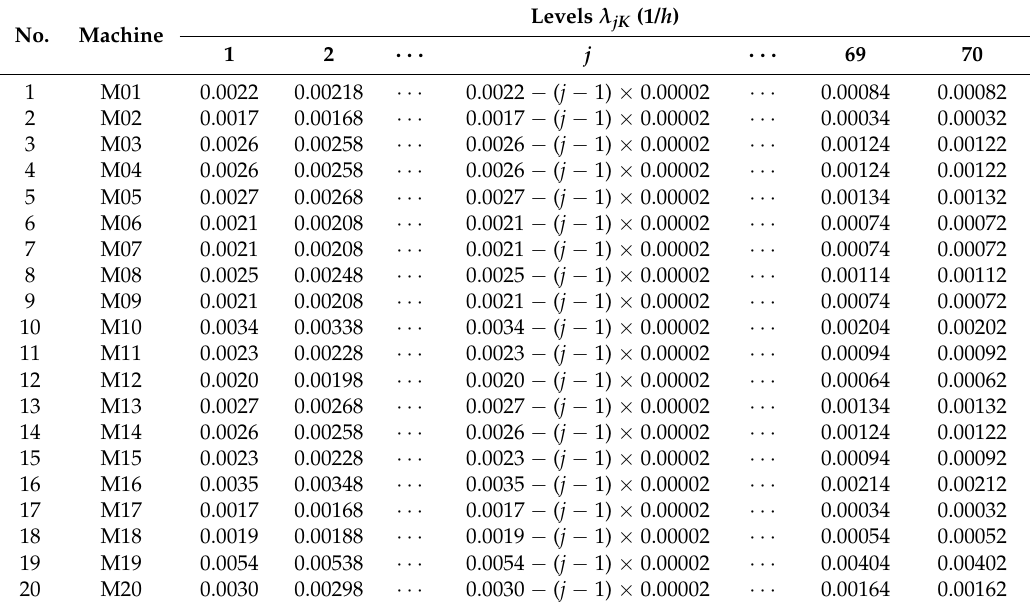
Table 2. The levels of the uniform design for the machines’ failure